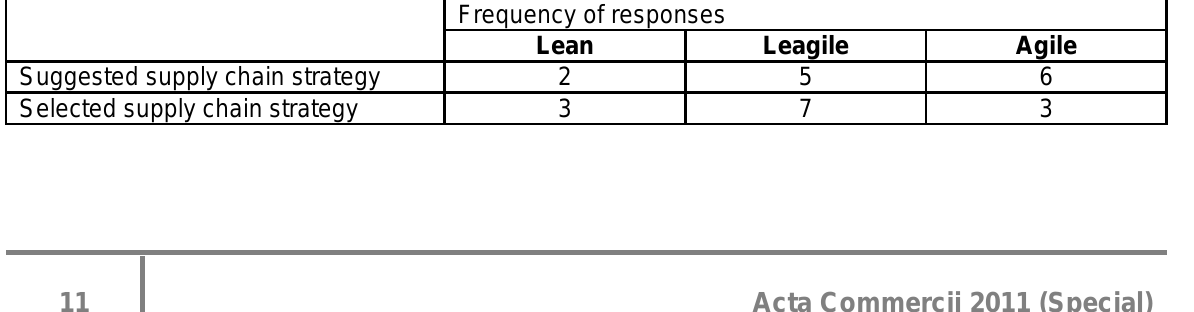
Table 4: Focus of organisations’ supply chain strategy ( n =